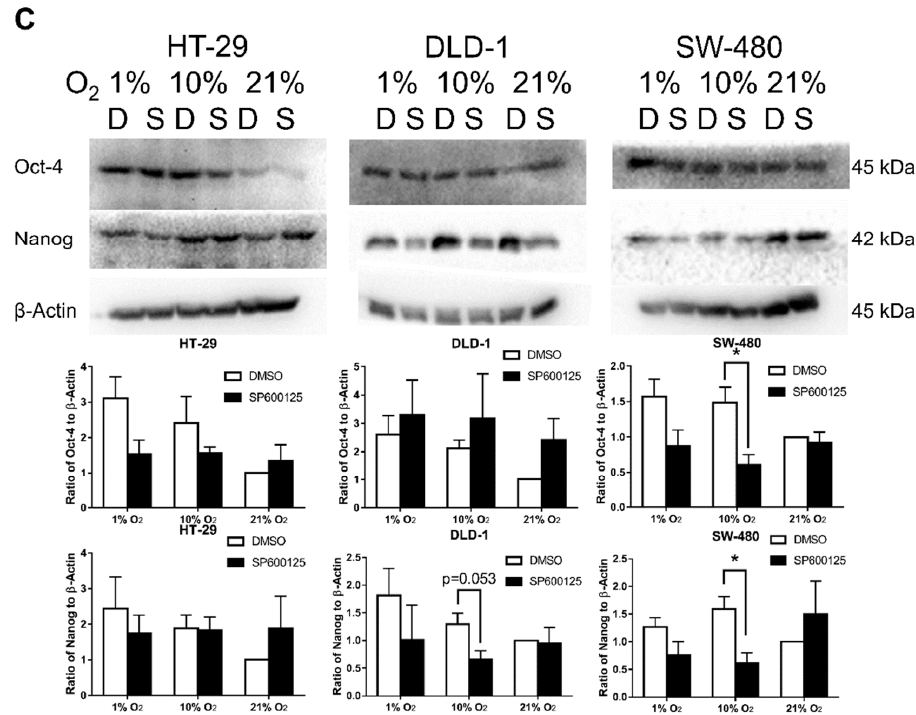
Figure 6. Oct-4 and Nanog expressions under different oxygen levels. The key stemness maintenance markers Oct-4 ( A ) and Nanog ( B ) changes in lower oxygen levels were evaluated by Western blotting. Results showed that both stemness maintenance markers were generally up-regulated under lower oxygen levels with significant up-regulation of Oct-4 in HT-29 (1% and 10% O 2 ) and DLD-1 (10% O 2 ) and Nanog in SW-480 (10% O 2 ). For the impact of JNK inhibitor SP600125 (10 µM) on Oct-4 ( C ), diverse impacts with general down-regulation in lower oxygen levels among HT-29 and SW-480 and slight up-regulation in DLD-1 by SP600125 were found. While for Nanog, general inhibition in 1% and 10% O 2 was discovered among all three studied cell lines with greater impact on DLD-1 and SW-480 ( C ). The data (means ± SEM) were expressed as the relative expression compared with 21% O 2 group, N = 9 (HT-29 and DLD-1) or 10 (SW-480) ( A , B ) The data (means ± SEM) were expressed as the relative expression compared with DMSO 21% O 2 group. N = 9 (HT-29 and DLD-1) or 10 (SW-480) for DMSO group; N = 4 (HT-29) or 5 (DLD-1 and SW-480) for SP600125 group ( C ) * p < 0.05, ** p < 0.01. D: DMSO (0.1%), S: SP600125 (10 µM).